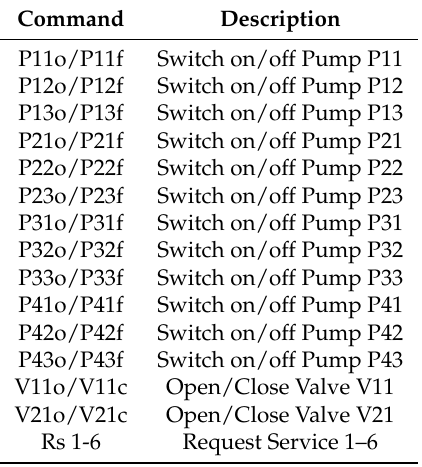
Figure 8. The structure of the tank system. Table 2. Description of commands in the tank system.